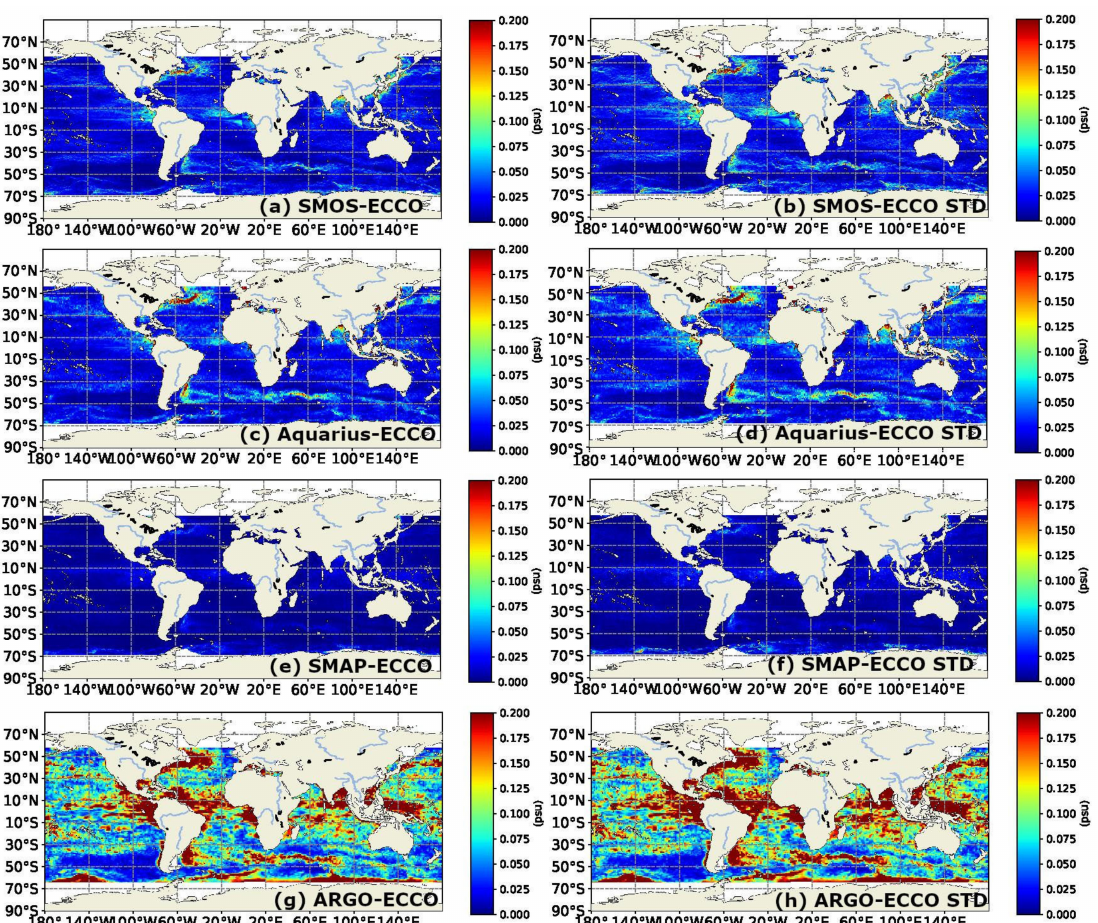
Figure 4. Maps of the absolute mean ( left column ) and standard deviation ( right column ) of differ- ences between monthly ( a , b ) SMOS, ( c , d ) Aquarius, ( e , f ) SMAP, and ( g , h ) Argo-based and ECCO SSS over the 1-year model